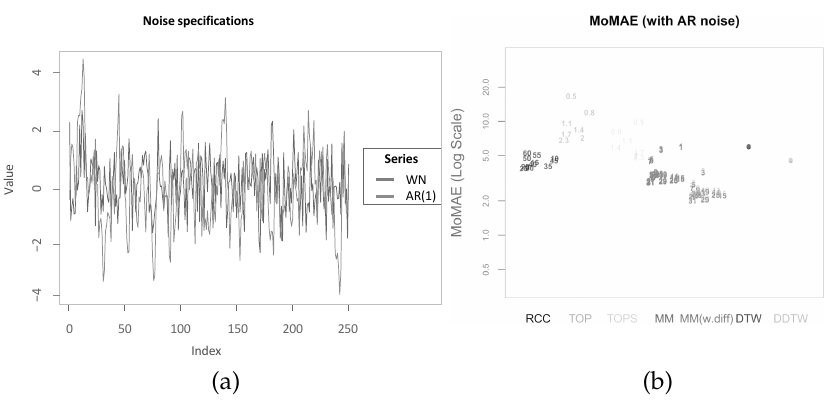
Figure 16. Robustness check towards different noise specification. ( a ) Different noise specifications; ( b ) MoMAE with underlying AR